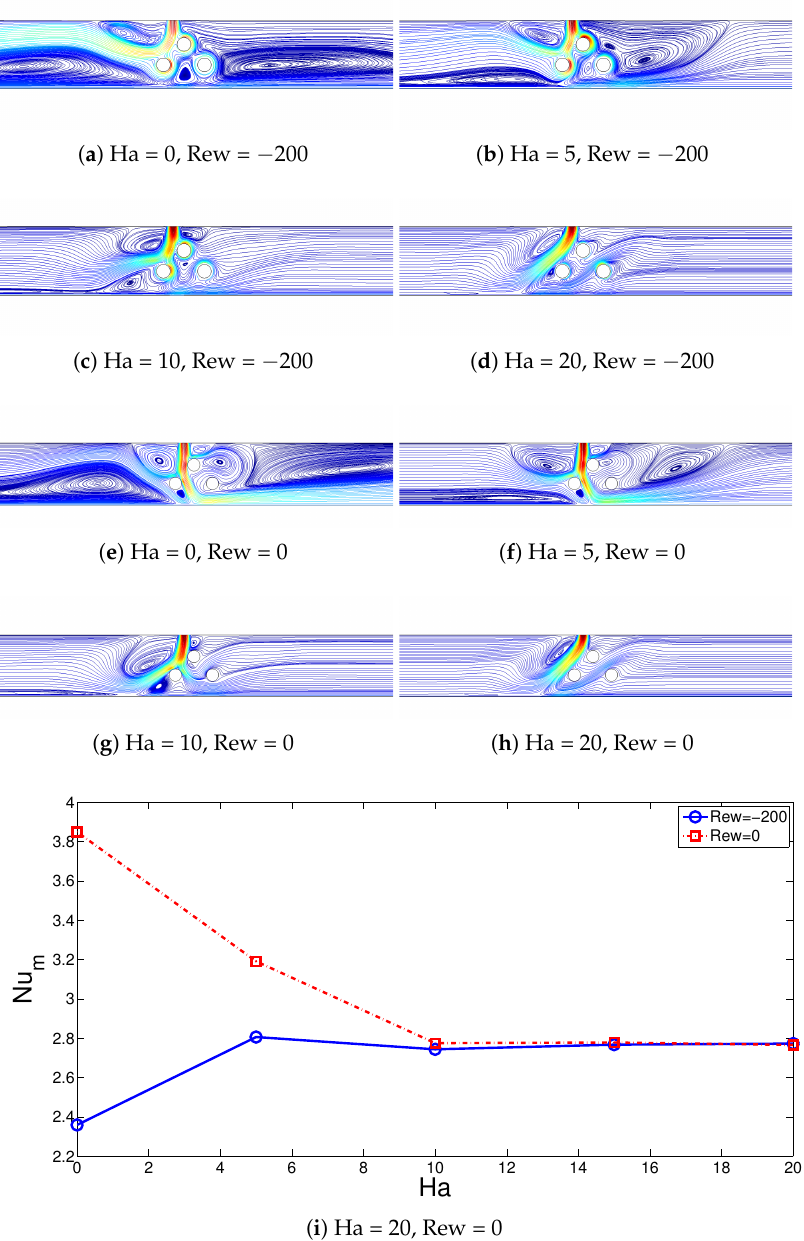
Figure 8. Impacts of MGF strength on the streamline distributions considering rotating ( a – d ), non- rotating CC cases ( e – h ) and on the average Nu variations ( i ) (VR = 0.25, Mx = −